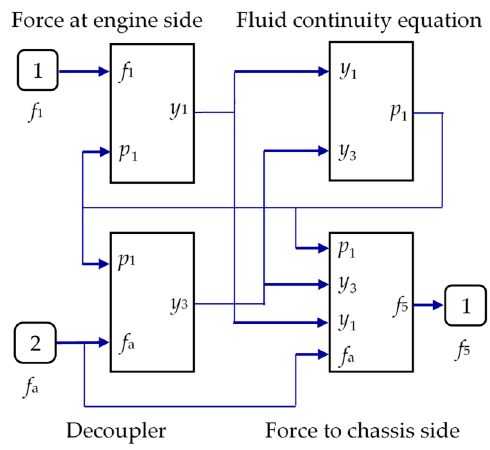
Figure 2. ACM simulation model.